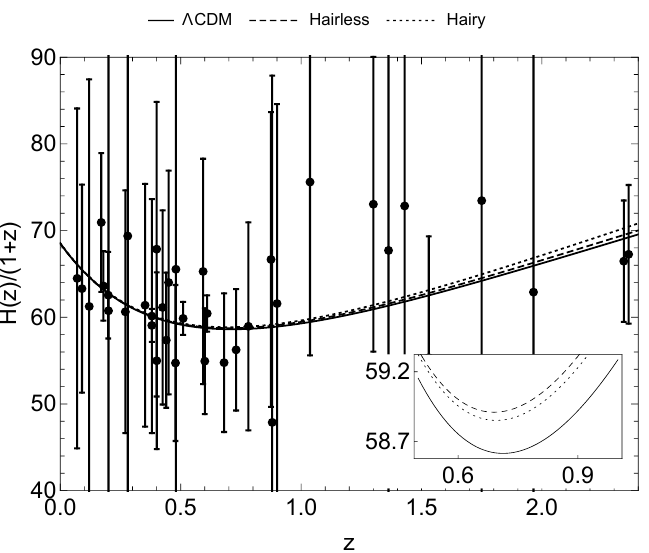
p 1 − Ω m + Ω m (1 + z ) 3